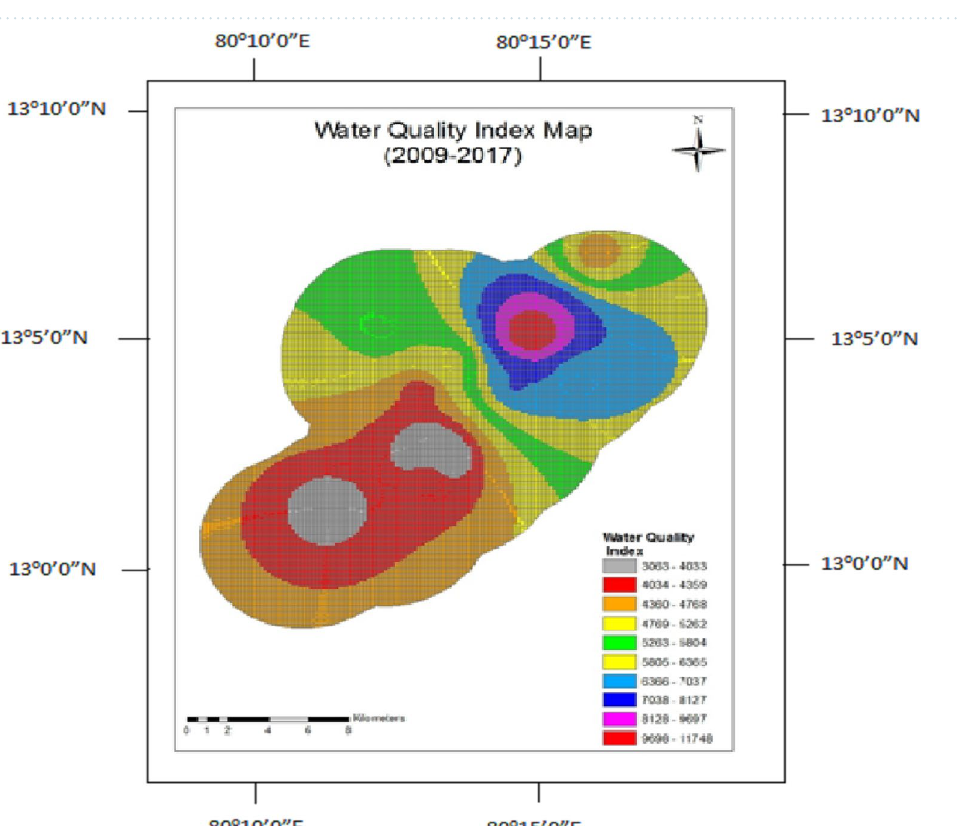
Figure 8. Water quality index map for